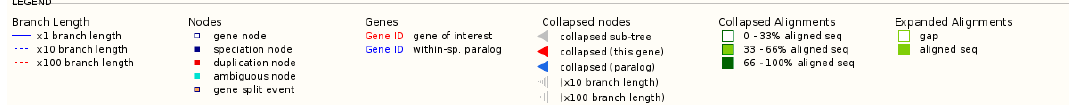
Figure 7. Gene tree for human CYP26A1 , 26B1 , 26C1 , and 51A1 built using Ensembl 84. These CYP26 and CYP51 family genes are paralogs to each other derived from the same ancestral gene via duplication events. The gene tree includes a total of 260 genes from various species. The total number of speciation nodes is 232, and the number of duplication is 12. The number of ambiguous nodes is 15, and there is no gene split event.